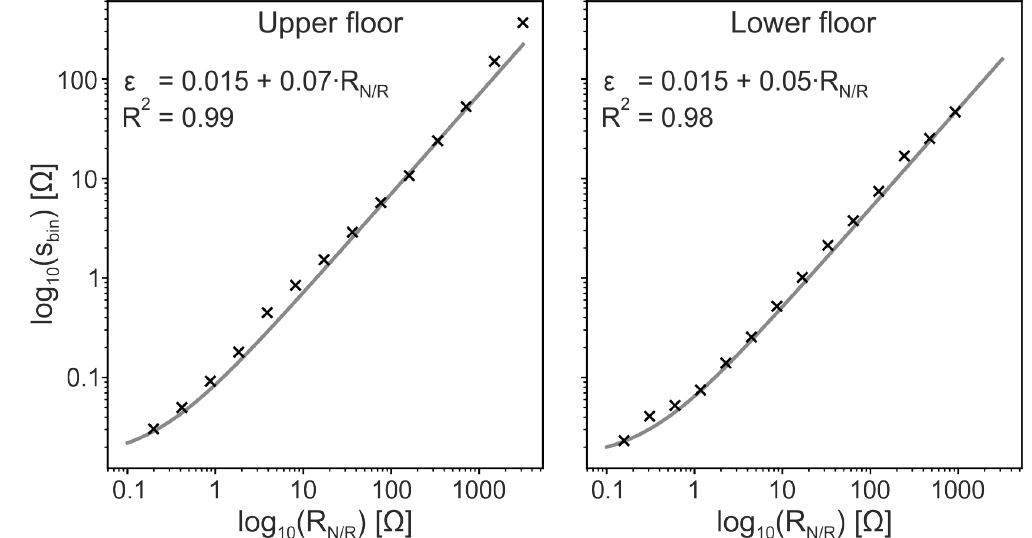
Figure 7. Standard deviation of the reciprocal errors, which were binned according to their corresponding measured transfer resistance. The fitted error model is shown as a grey line. The error model parameters and goodness of fit are given for each data